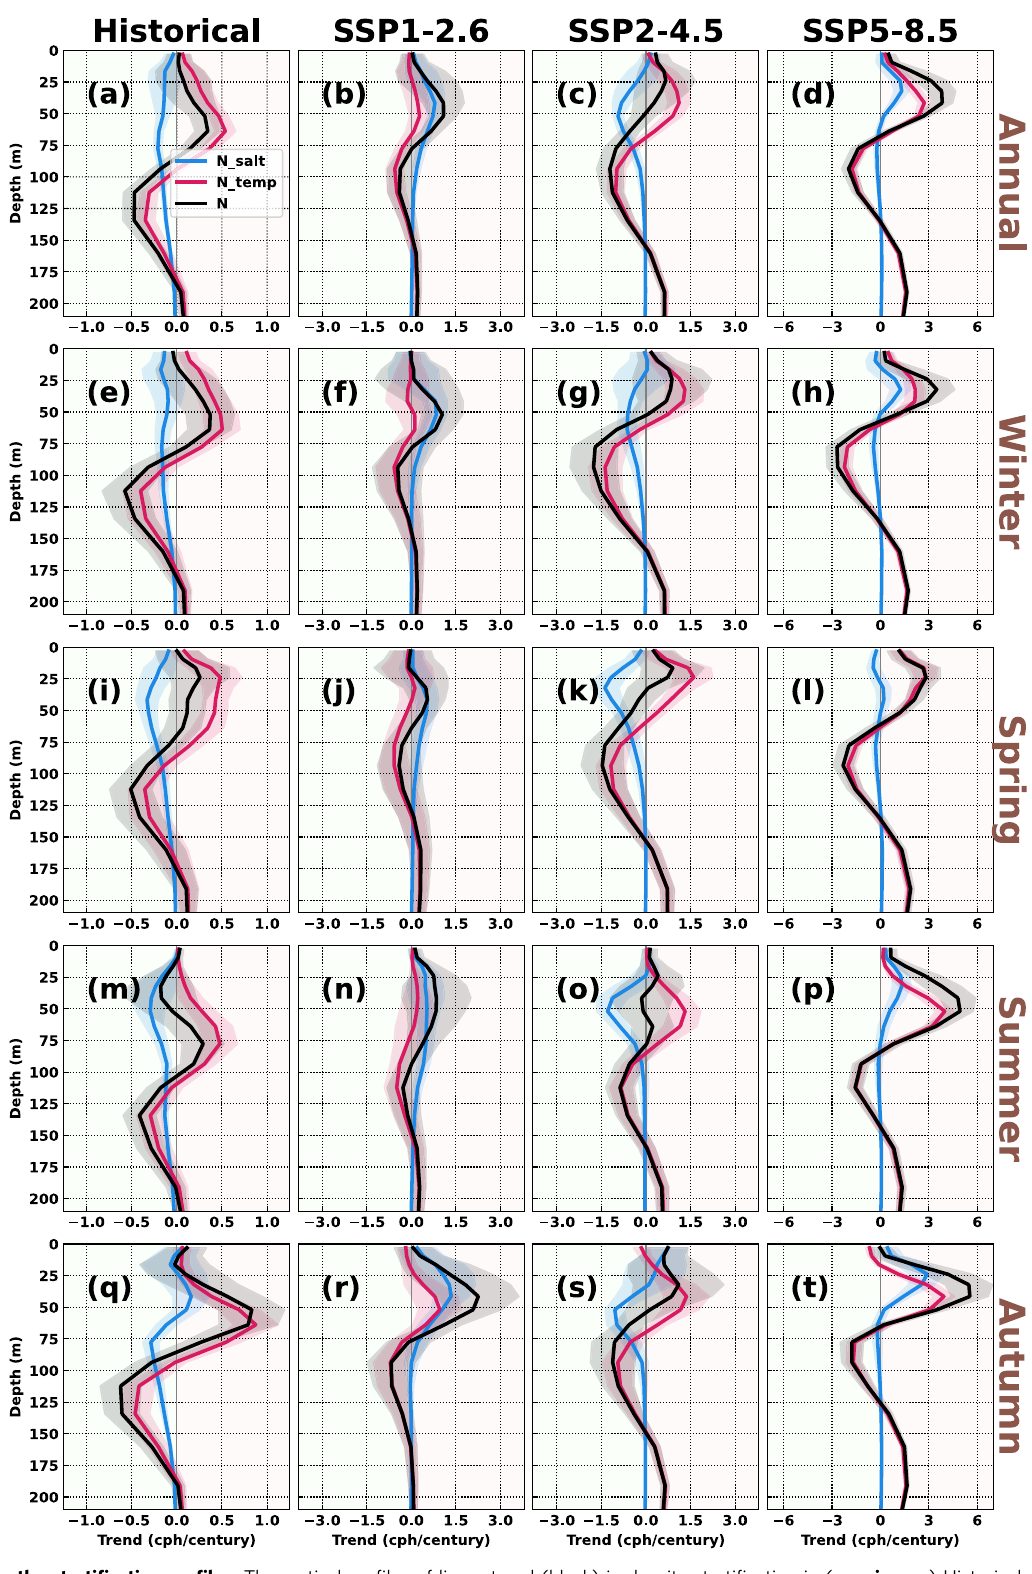
Fig. 3 Trend in the strati fi cation pro fi les. The vertical pro fi les of linear trend (black) in density strati fi cation in ( a , e , i , m , q ) Historical, b , f , j , n , r SSP1-2.6, c , g , k , o , s SSP2-4.5, and ( d , h , l , p , t ) SSP5-8.5 scenarios. Red and blue lines represent the effect of temperature and salinity on the strati fi cation trend, respectively. The shaded region indicates the 95% con fi dence interval. Seasons are considered as follows: e – h winter is